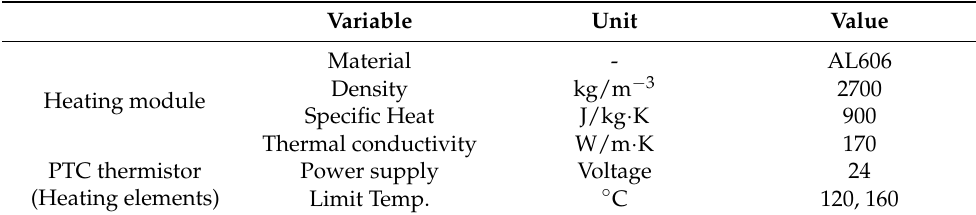
Table 1. Specifications of heating module and PTC thermistor.